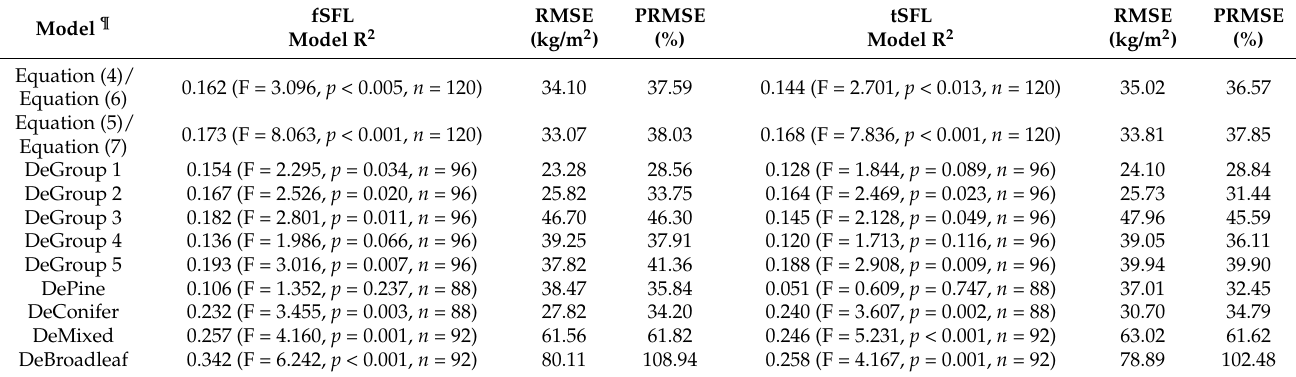
Table 4. Summary of the performance of fSFL and fSFL models based on